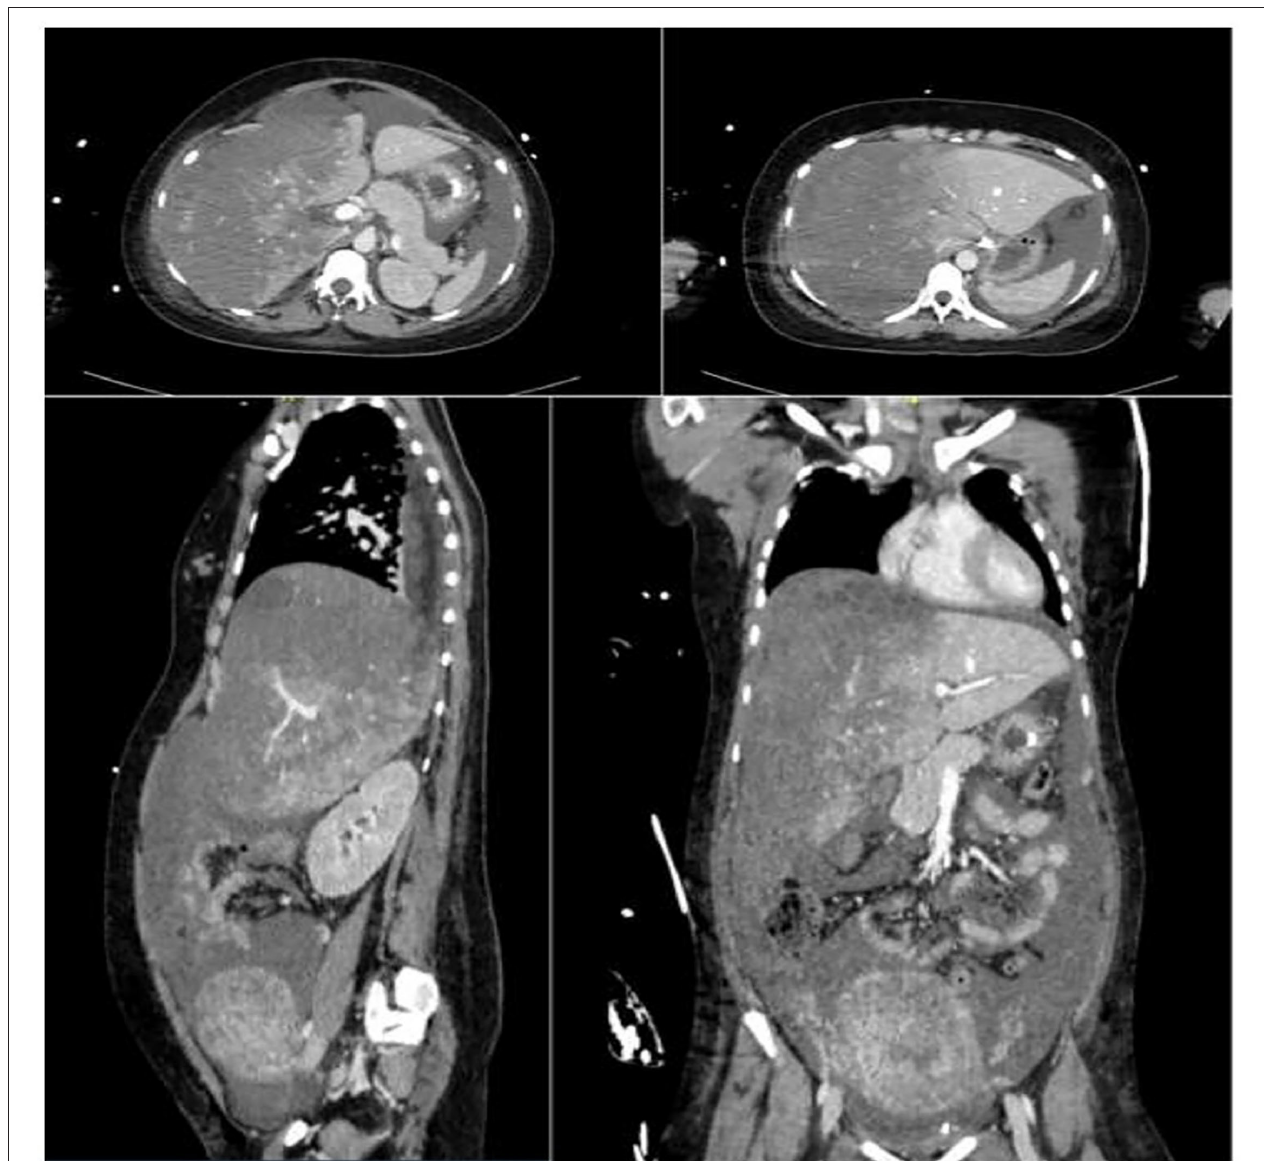
FIGURE 1 | Computed tomography images of the large right liver haematoma with haemoperitoneum.